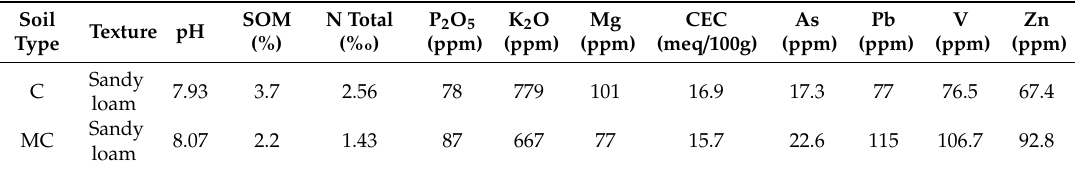
Table 1. Physico–chemical parameters and metal(loid) content of soil sampled in two di ff erent sites (C—control and MC—moderate contamination) in the “Valle del Sacco” area (Lazio Region, Central